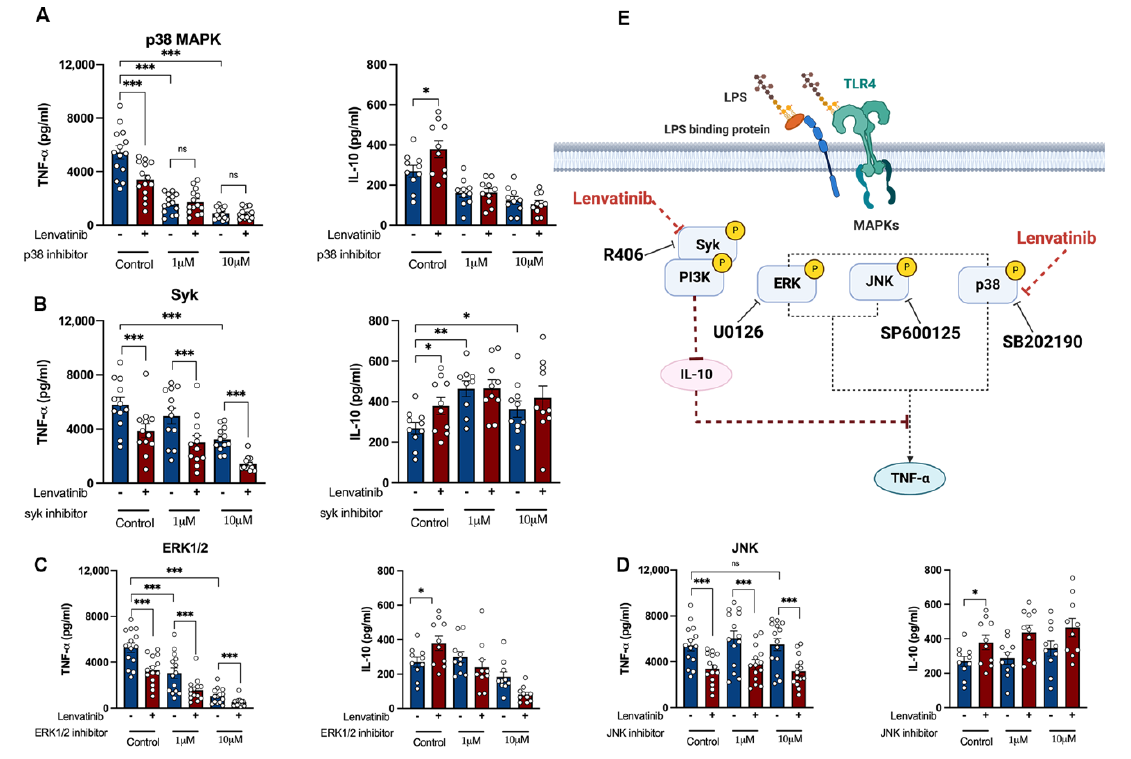
Figure 6. Effects of TLR4 downstream kinase inhibitors on Lenvatinib-mediated immunomodula- tion. ( A – D ) Monocytes were treated with selective inhibitors against kinases within the TLR4 sig-